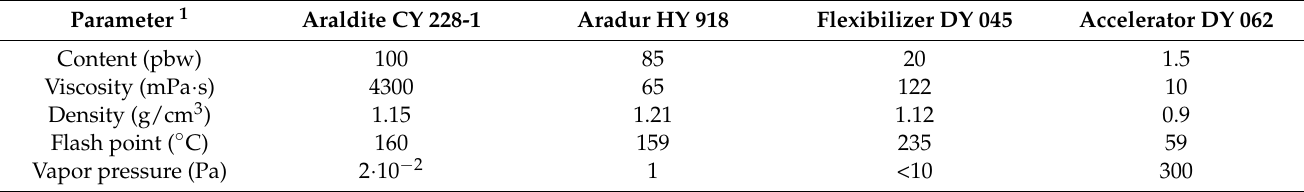
Table 1. Properties of the thermosetting resin used for fabrication of filled composites.